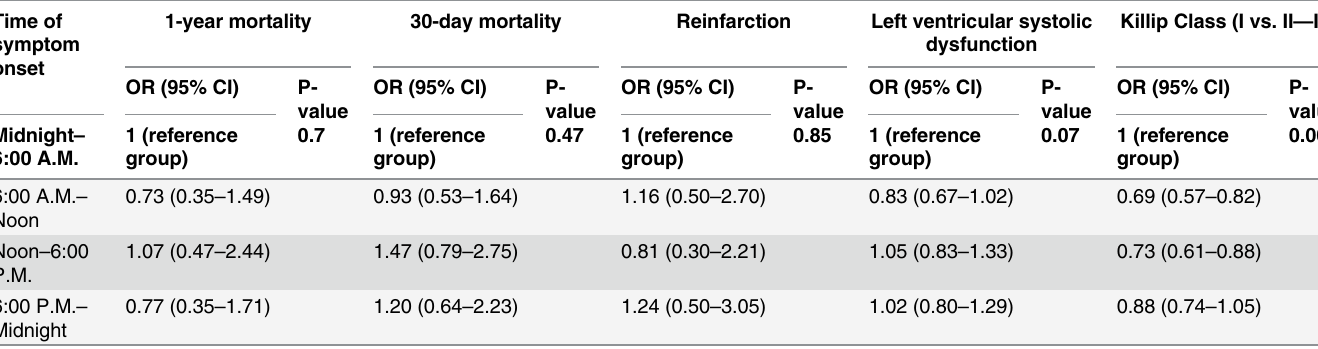
Table 4. Multivariable logistic regression analysis of clinical